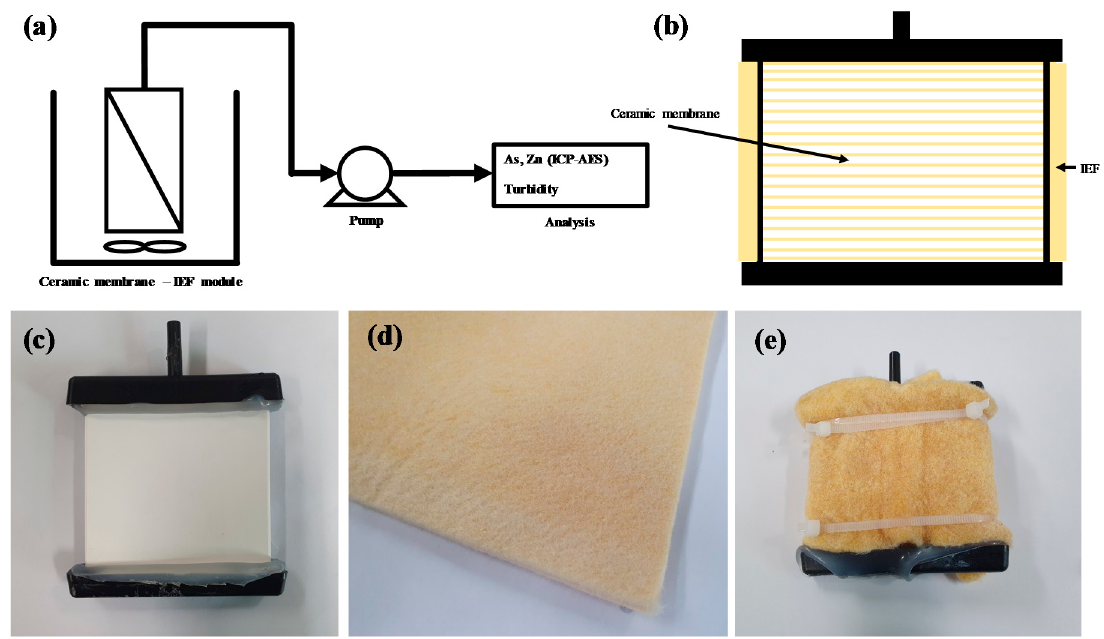
Figure 1. Schematic diagram of the (a) experimental setup and (b) ion-exchange fabric/ceramic Figure1. Schematicdiagramofthe( a )experimentalsetupand( b )ion-exchangefabric / ceramicmembrane membrane module. Digital images of (c) ceramic membrane, (d) ion-exchange fabric, and (e) ion- module. Digital images of ( c ) ceramic membrane, ( d ) ion-exchange fabric, and ( e ) ion-exchange fabric / exchange fabric/ceramic membrane module. ceramic membrane